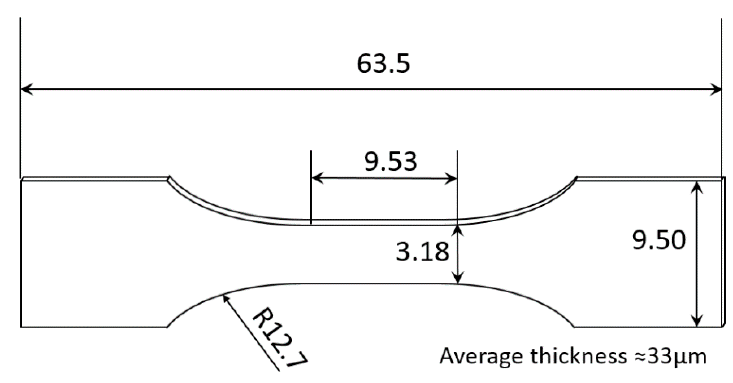
Figure 13. The dimension of test specimen (mm).